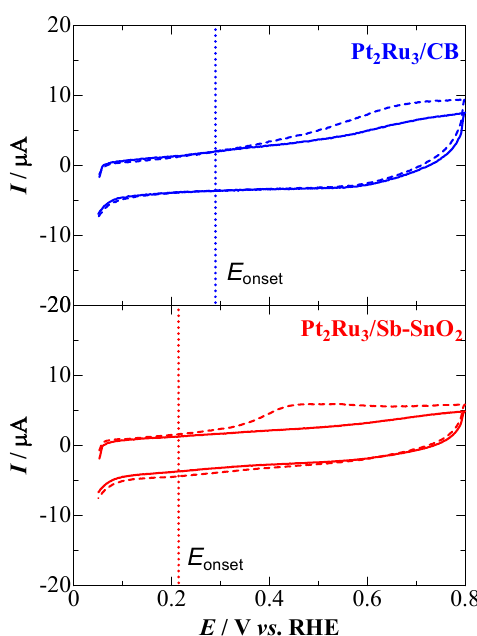
Figure 4. CO stripping voltammograms at Nafion-coated Pt 2 Ru 3 /CB and Pt 2 Ru 3 /Sb-SnO 2 electrodes measured in N 2 -purged 0.1 M HClO 4 at 70 ◦ C and a potential sweep rate of 0.02 V · s − 1 . The solid lines indicate the CV at the CO-free electrode. The vertical dotted line shows the onset potential ( E onset ) for the oxidation of adsorbed CO. Carbon monoxide was adsorbed on the working electrode by supplying 0.1 M HClO 4 solution saturated with 5% CO (He balance) at a mean linear flow rate of 10 cm · s − 1 (corresponding to a volume flow rate of 2 cm 3 · s − 1 ) for 30 min while maintaining the potential at 0.05 V.